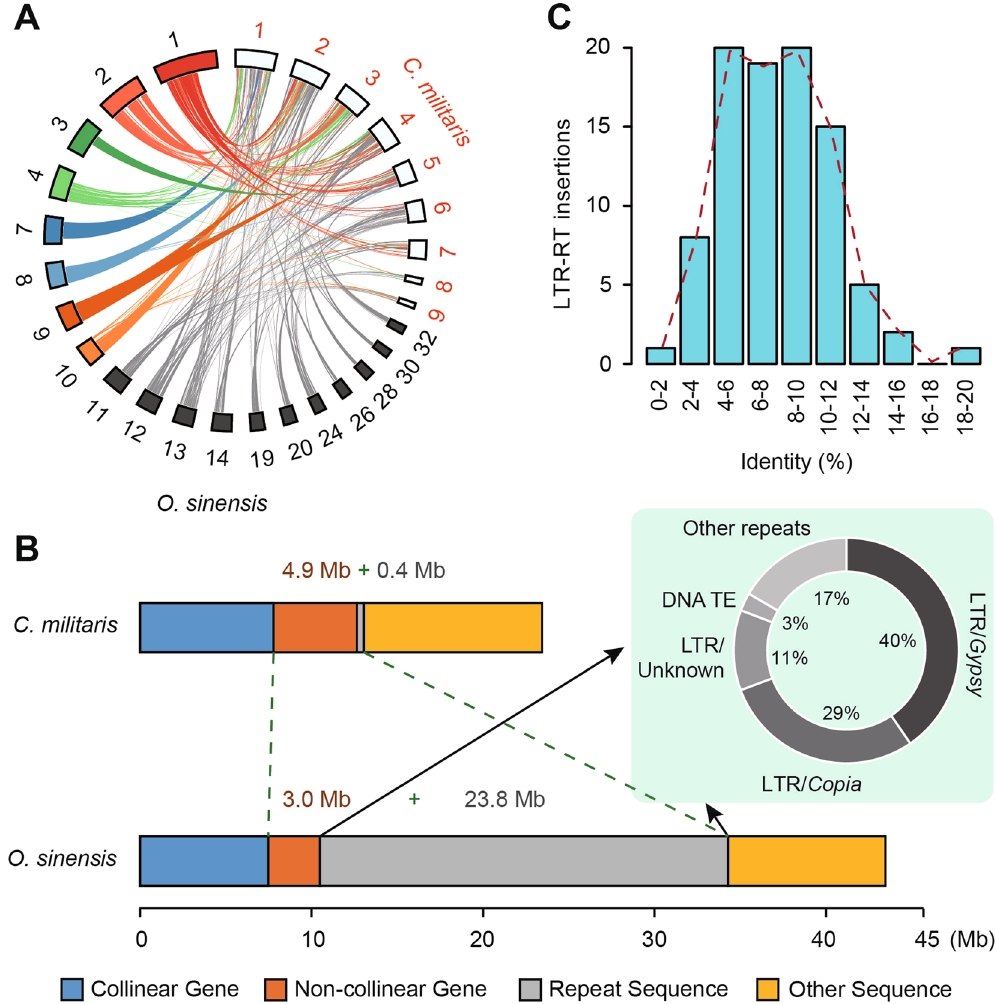
Figure 1. Genome size variation. ( A ) Collinear blocks between O . sinensis and C . militaris . The largest nine scaffolds of C. militaris are highlighted with red numbers. Whole scaffolds are depicted in Supplemental Figure S10. Collinear blocks are identified using MCScanX package with default parameters. ( B ) Differences in genomic composition. Approximate 23.4 Mb (72.7% of the total genome) and 43.5 Mb (37.5%) of the C . militaris and O . sinensis genomes are mapped to 308 syntenic blocks. Significant expansion of LTR retrotransposons and the loss of non-collinear genes are observed. ( C ) LTR retrotransposon expansion in collinear blocks of O . sinensis . X-axis indicates percent identity of LTRs, whereas y-axis represents the number of LTR retrotransposon